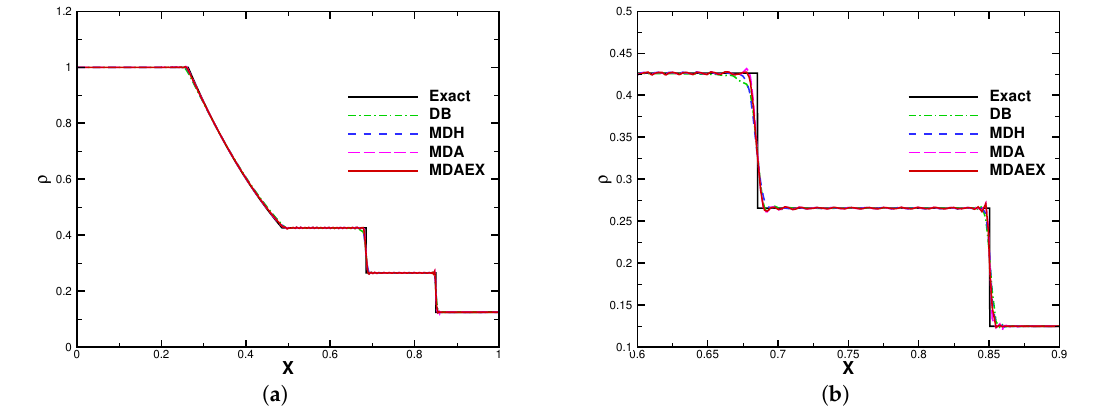
Figure 6. Density solution for the Sod problem with 100 elements at t = 0.2, P 4. ( a ) Overview; ( b ) zoomed in results.